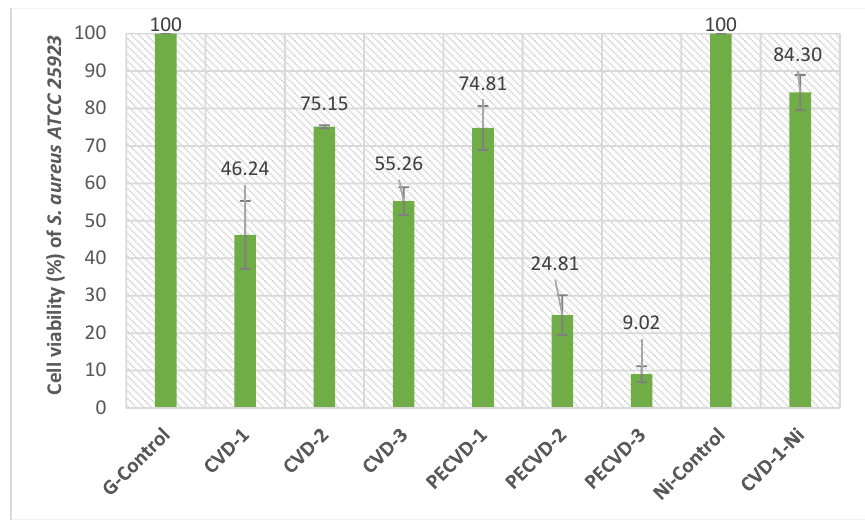
Figure 7. Cell viability (%) of Escherichia coli ATCC 35218 .